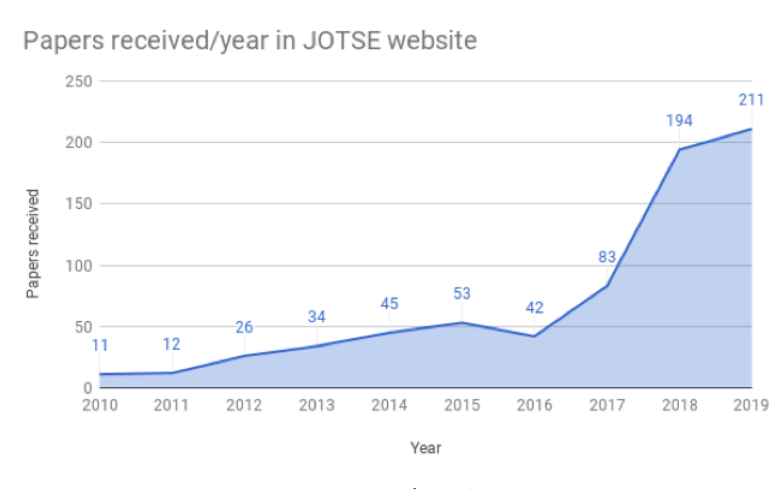
Figure 1. JOTSE's